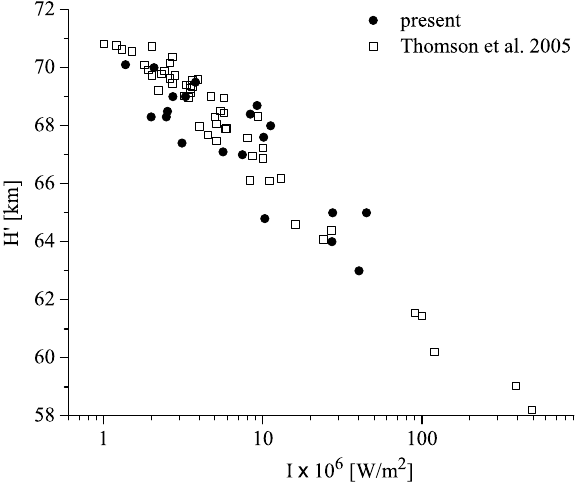
Fig. 7. Ionospheric sharpness, β versus X-ray irradiance. Present results: circles; Thomson et al. (2005): squares. Fig. 8. Reflection height, H 0 versus X-ray irradiance. Present re- sults: circles; Thomson et al. (2005): squares.